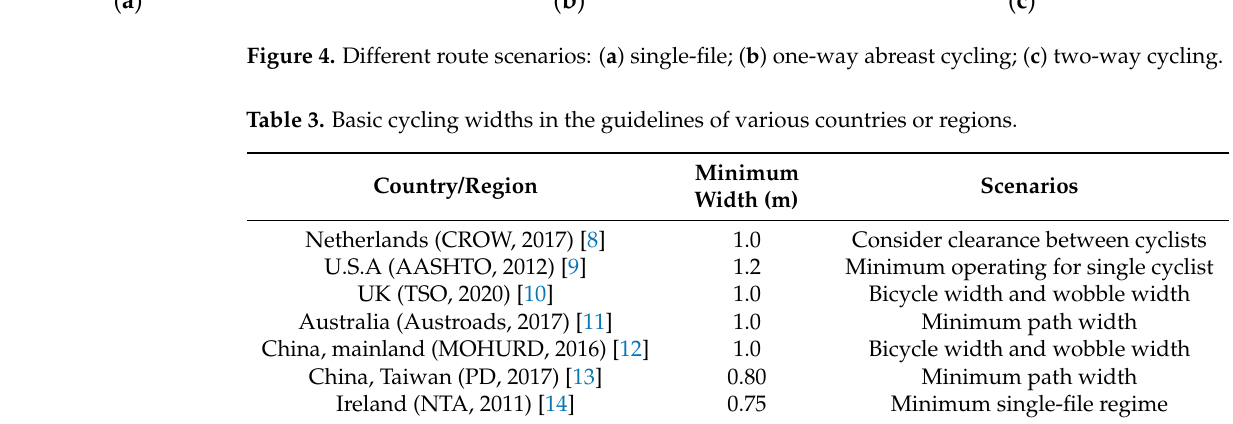
Figure 4. Different route scenarios: ( a ) single-file; ( b ) one-way abreast cycling; ( c ) two-way cycling.